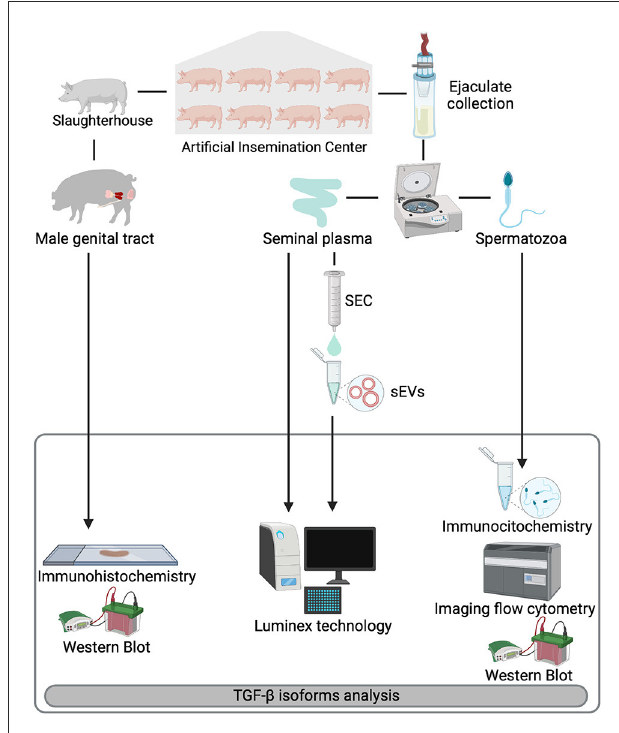
FIGURE1 Overview of the experimental design. Entire ejaculates and selected reproductive organs [testis, epididymis, and accessory sex glands (prostate, seminal vesicles, and bulbourethral glands)] were collected from eight healthy breeding male pigs included as semen providers in artificial insemination programs. Ejaculates were centrifuged to separate spermatozoa from seminal plasma (SP). SP samples were subjected to a size-exclusion chromatography (SEC) based protocol for isolation of seminal extracellular vesicles (sEVs). Expression of TGF- β 1, - β 2, and - β 3 were analyzed in reproductive tissues (immunohistochemistry), spermatozoa (immunocytochemistry and imaging flow cytometry) and in SP and sEVs (Luminex xMAP ® technology). Presence of TGF- β isoforms in the reproductive tissues and spermatozoa was confirmed by Western